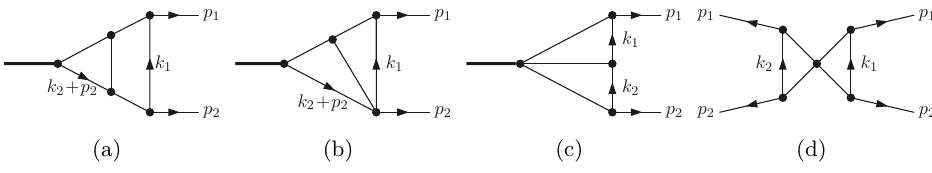
Figure 3 . Representative two-loop planar triangles that admit a d log